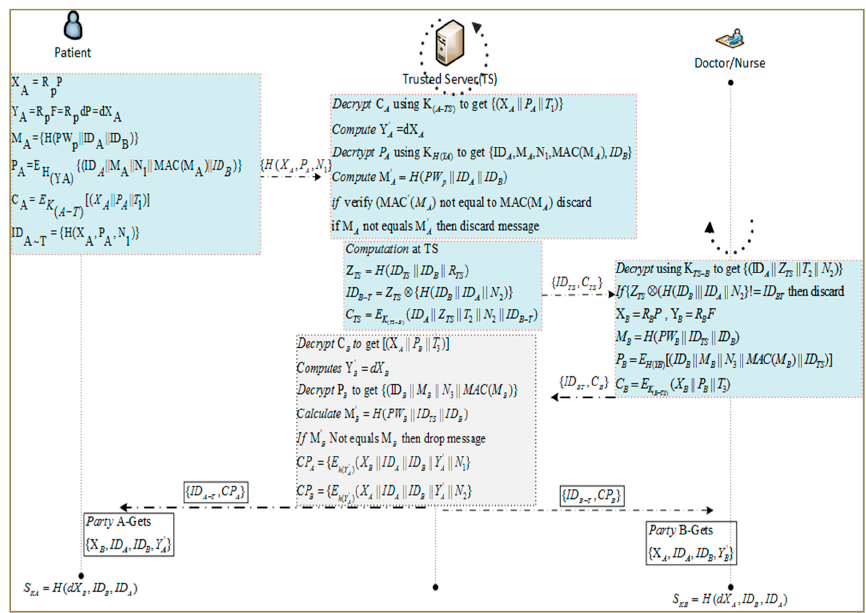
Figure 3. Secure authentication and prescription safety protocol steps.